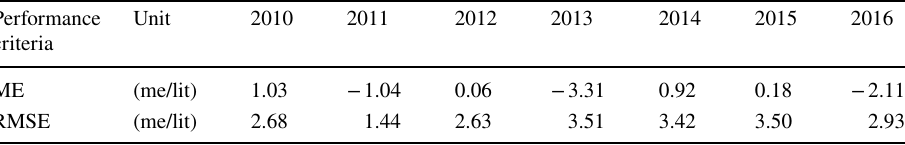
Table 6 The results of performance criteria for sulfate concentration